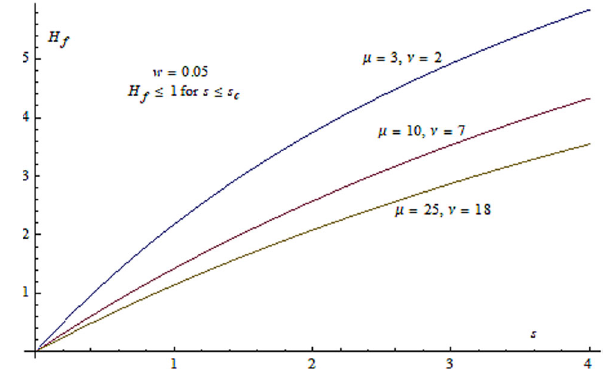
Fig. 7 Behavior of the extended Hod function H f ( x c , s ) for w = 0 . 05 forvariousvaluesof μ and ν .Wedisplaythecriticalvaluesforthereader to verify that the Hod function truly embodies the hoop conjecture. The values are: x c = 1 . 3322 , s c = 0 . 4151 ( μ = 3 ,ν = 2); x c = 1 . 352 , s c = 0 . 6873 ( μ = 10 ,ν = 7); x c = 1 . 1870 , s c = 0 .